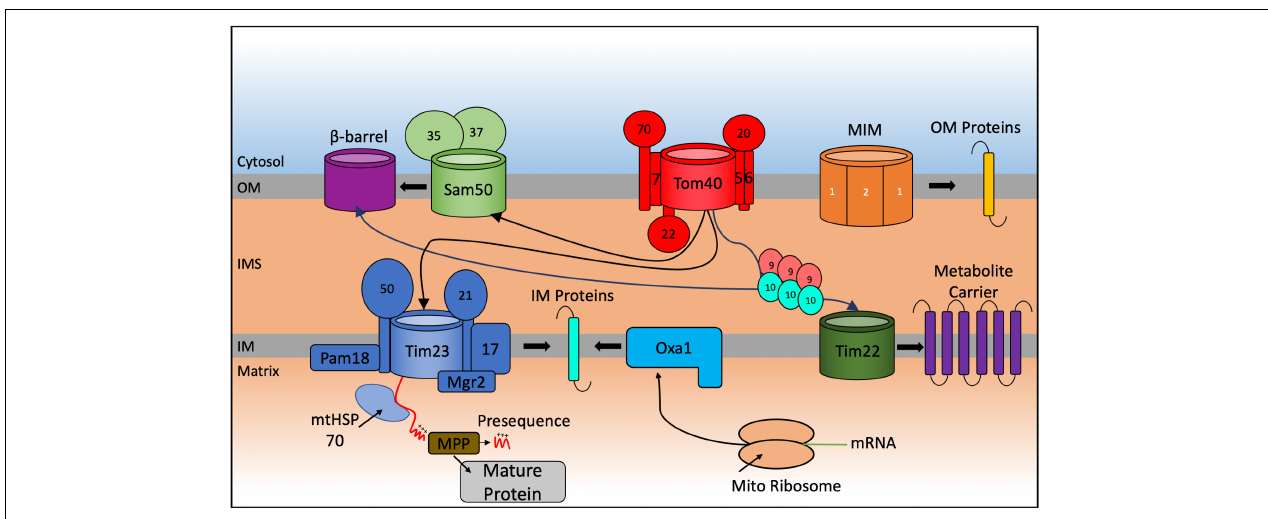
FIGURE 1 | Schematic representation of the general import pathways for proteins destined for localization to the mitochondria. Incoming nuclear-encoded proteins destined for import into the mitochondria follow a number of particular import pathways depending on the sub compartment where they become localized. Matrix targeted proteins follow the presequence pathway, passing through the TOM40, and TIM23 translocases where they become cleaved by matrix processing proteins (MPP) in the matrix to form the mature protein. Preproteins targeted to the outer membrane (OM) are inserted by the Sam complex if they are β -barrel proteins and via the mitochondrial import machinery (MIM) if they are α -helical containing proteins. Integration of preproteins into the inner membrane (IM) involves interaction with the Tim9-Tim10 chaperone complex that targets proteins to the TIM22 translocase for membrane insertion or via a variation of the TIM23 complex that promotes integration of the protein into the IM. Mitochondrial encoded proteins are synthesized on mito ribosomes located in the matrix and inserted into the IM via the Oxa1